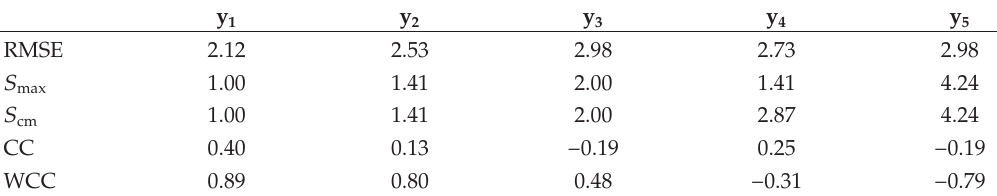
Table 2: Evaluation of reconstructions depicted in Figure 1.